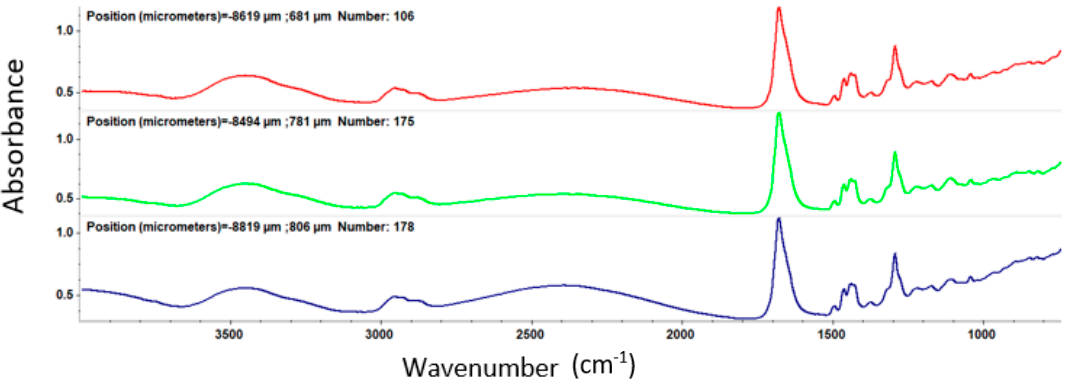
Figure 8. IR spectra of PVP/ZnO@LiN coatings at 300 mJ/cm 2 laser fluence.